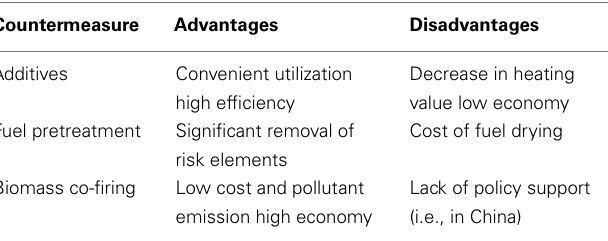
Table 5 | Comparison of the three countermeasures of biomass